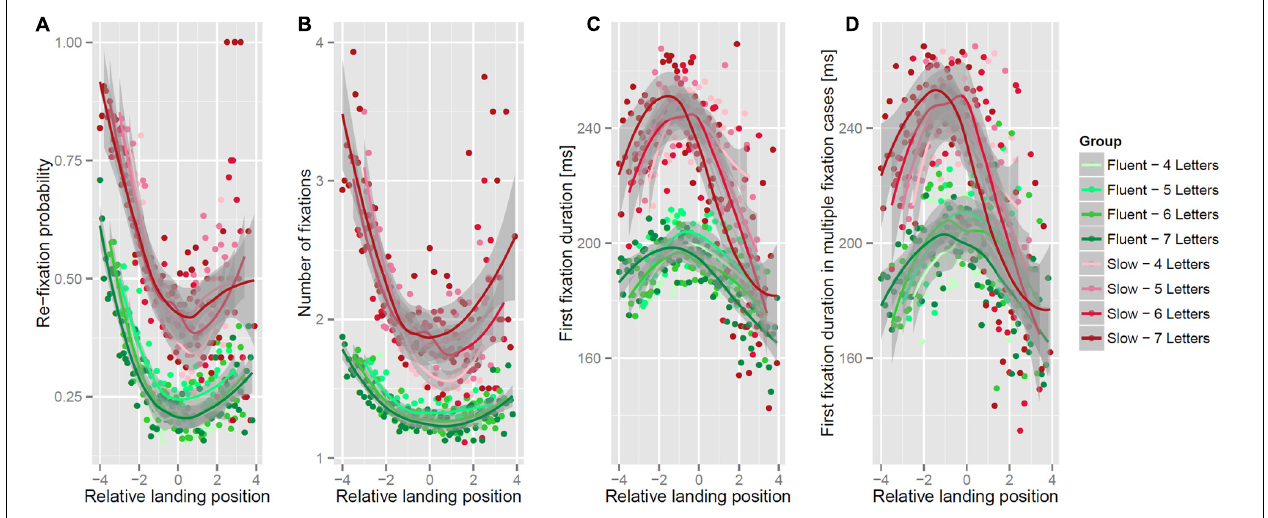
FIGURE 3 | Re-fixation probability (A) number of fixations (B), first fixation duration (C) and the first fixation duration of multiple fixation cases (D) in relation to centered initial landing position for both groups